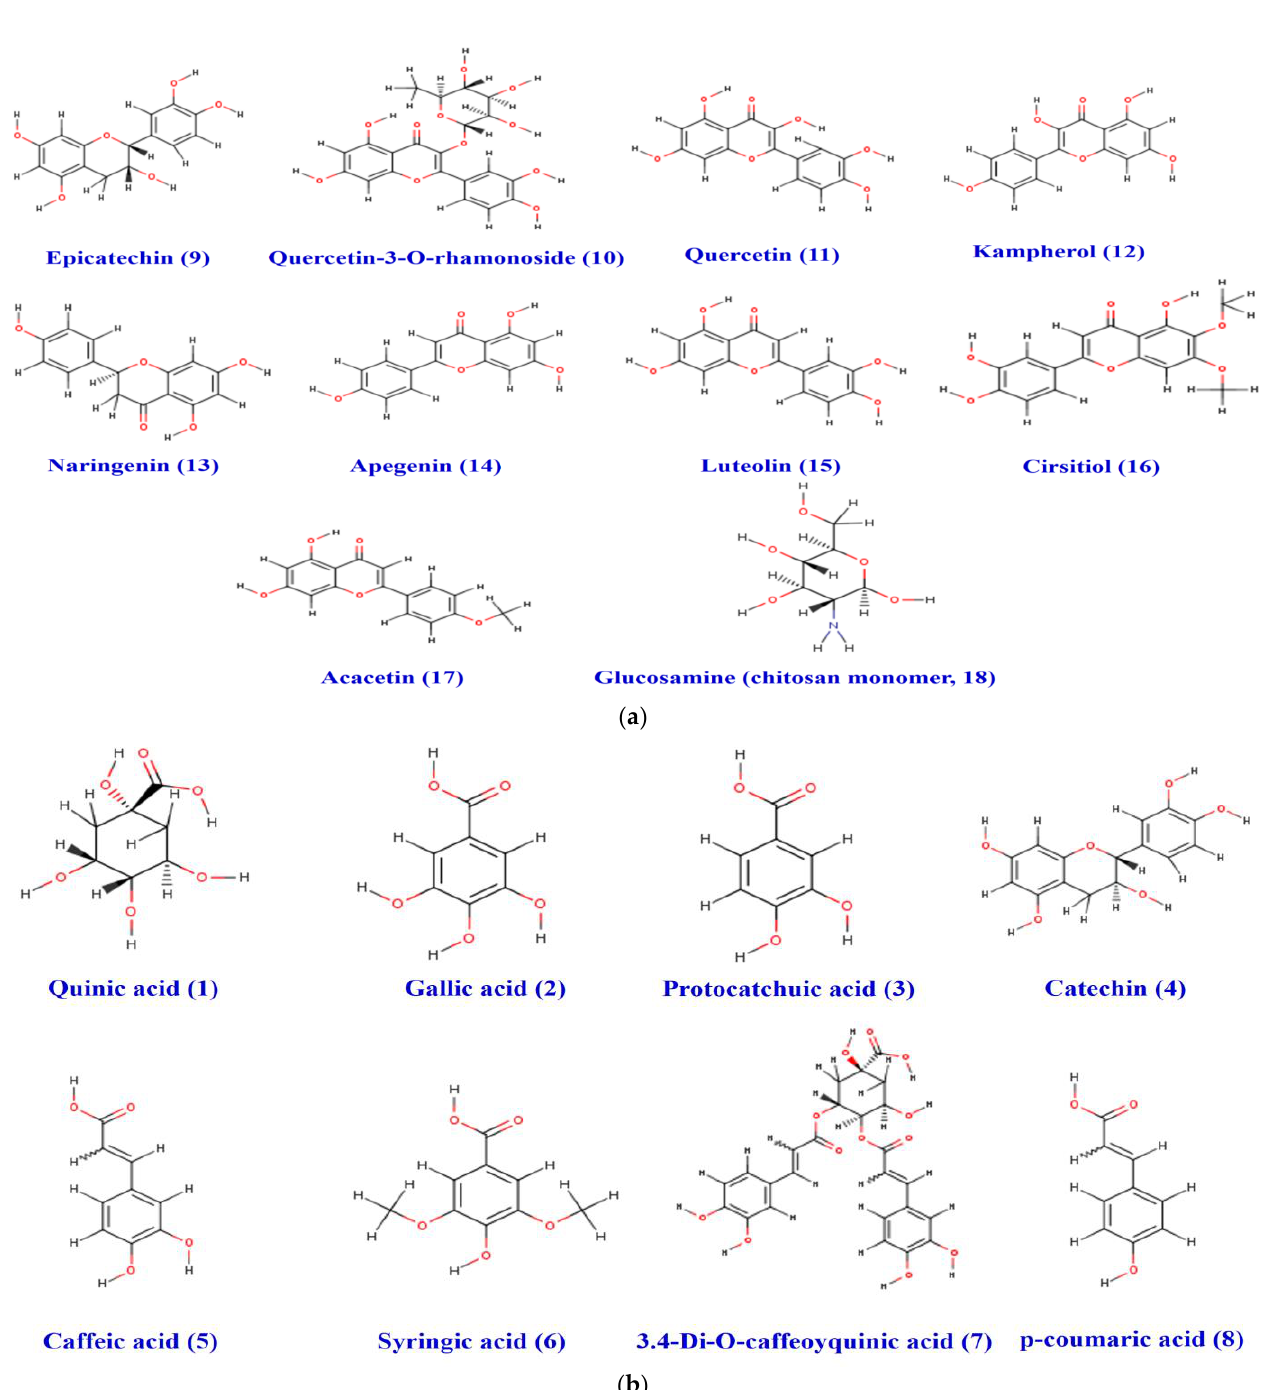
Figure 9. ( a ) Chemical structure of the acidic phenols (1 – 8) identified in the pomegranate fruit peel. ( b ) Structure of the different flavonoids (9 – 18) and chitosan monomer identified in the pomegranate fruit peel.